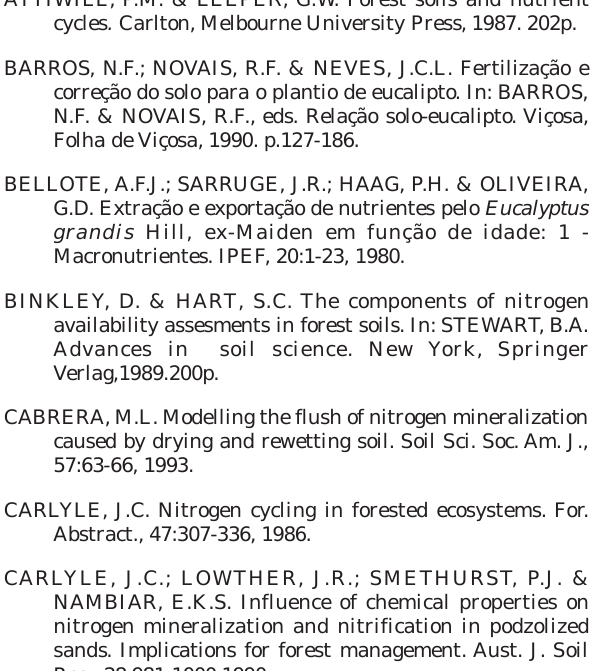
Figura 4. Valores de N mineralizado (N ) observados M e estimados pelas equações I e II, em condições de campo, no inverno (07/96) e no verão (12/96), na camada de 0-15 cm, após 45 dias de incuba- ção. Os valores estimados por estas equações, nos dois períodos, seguem a mesma